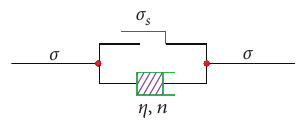
Figure 3: “Hohai creep model.”